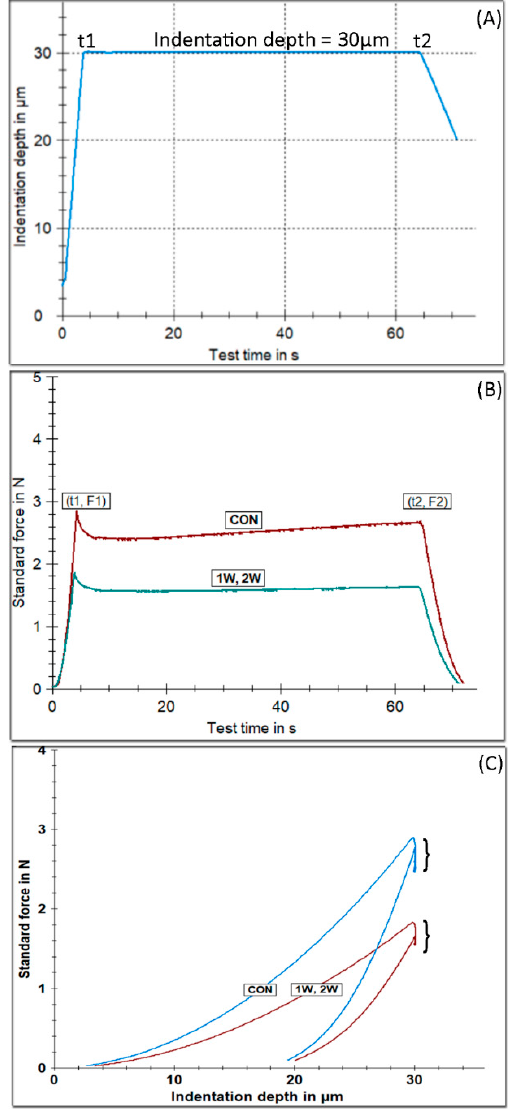
Figure 3. The tetragonal pulse applied for testing the mechanical properties of all of the groups tested, imposing a constant indentation depth for duration of 60 s ( A ). Representative force–time curves showing the force change over the loading period ( B ). Force indention depth curves. The vertical lines pointed by the brackets reflect the time of constant indentation depth ( C ).